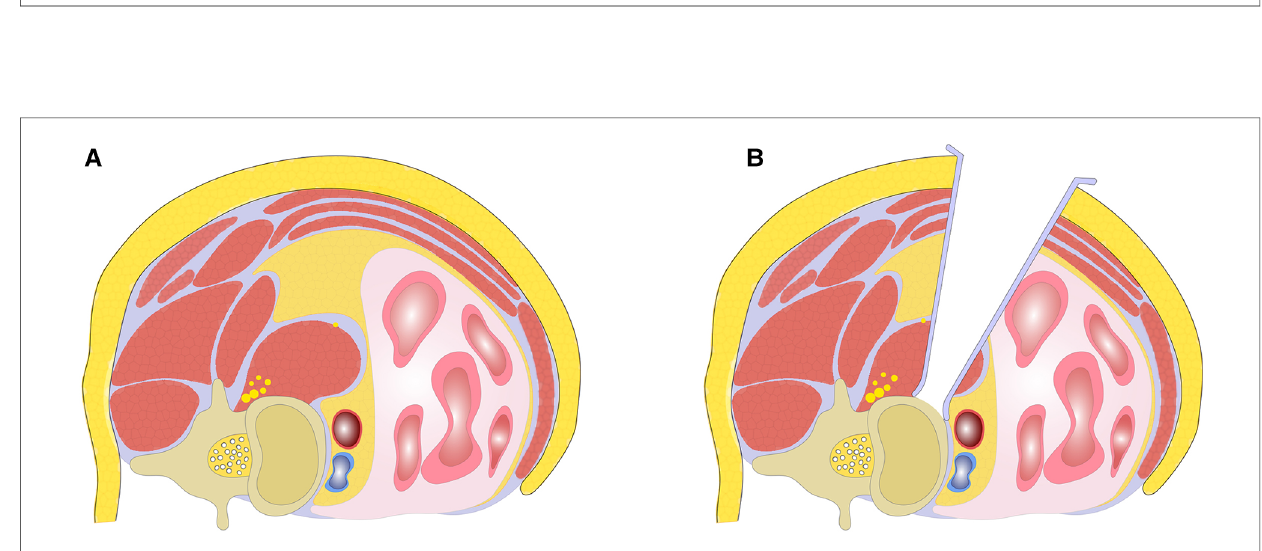
FIGURE 6 ( A ) Illustration of teardrop psoas blocking the oblique corridor; ( B ) achieving stable exposure with AP-OLIF technique by splitting anterior portion of